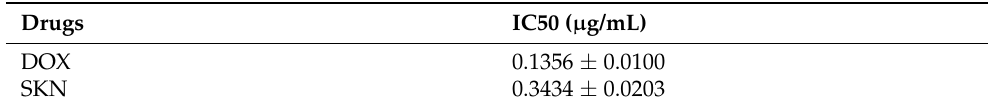
Figure 2. Toxicity of DOX ( A ), SKN ( B ), and dual drugs ( C ) in MDA-MB-231. ( D ) Combination synergy score analysis using SynergyFinder 2.0. * p < 0.05, ** p < 0.01, *** p < 0.001, and **** p < 0.0001 represent significant differences. Table 1. IC50 of DOX and SKN.